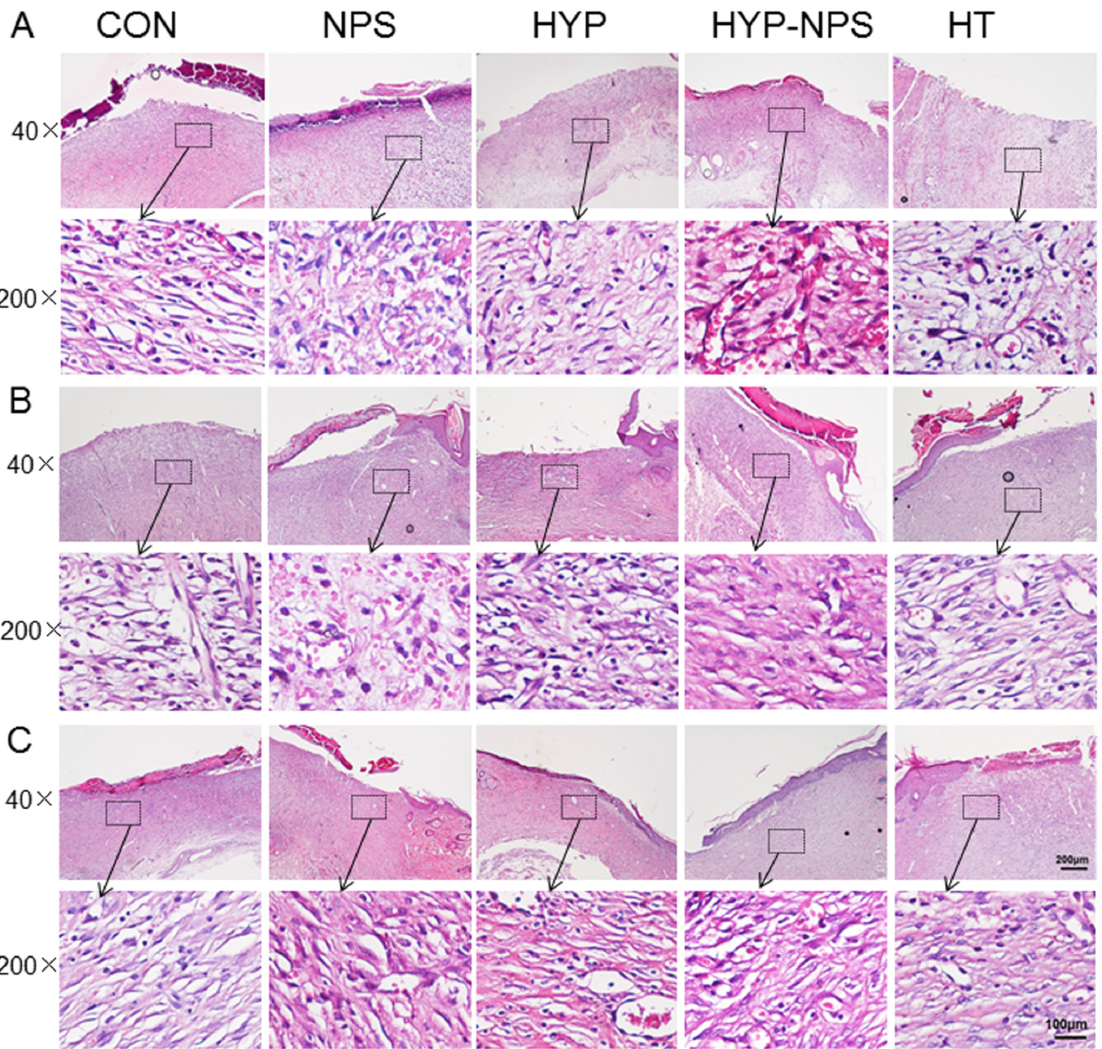
Figure 6. HYP-NPS inhibits the inflammatory response and accelerates re-epithelialization. H&E-stained microscopic sec- tions of healed incisions in rats on the 6th ( A ), 9th ( B ), and 12th ( C ) days. I represent inflammatory cells, B represents blood vessels, and F represents fibroblasts.